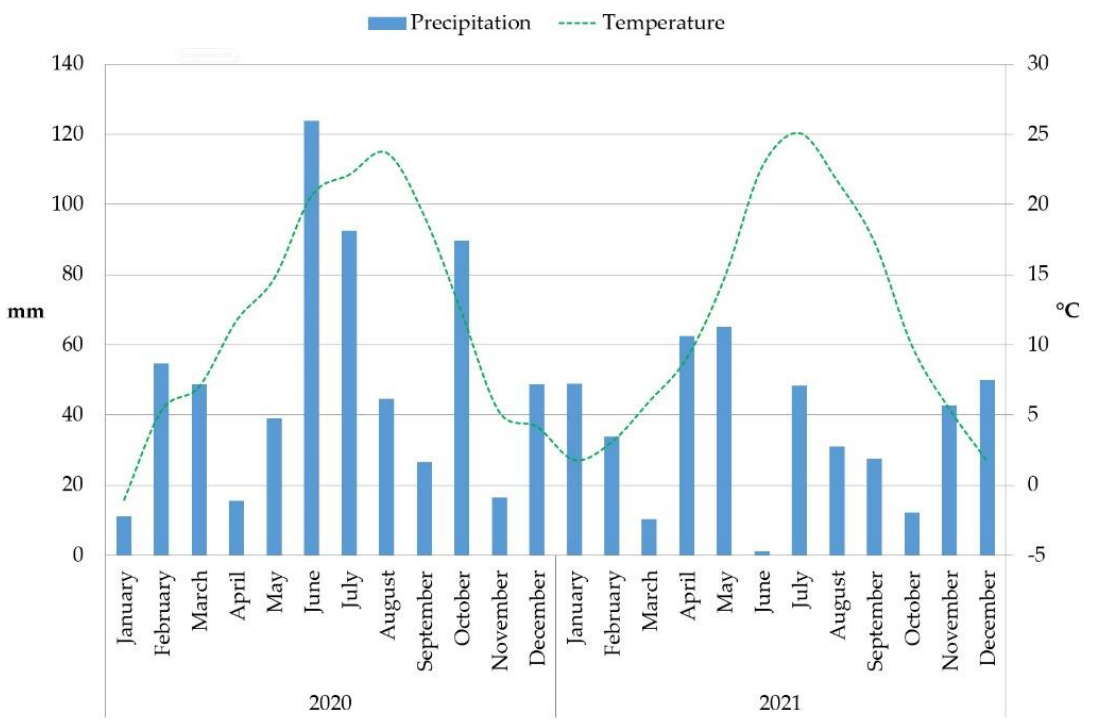
Figure 1. Monthly precipitation amount and average monthly temperature of experimental years (2020, 2021).